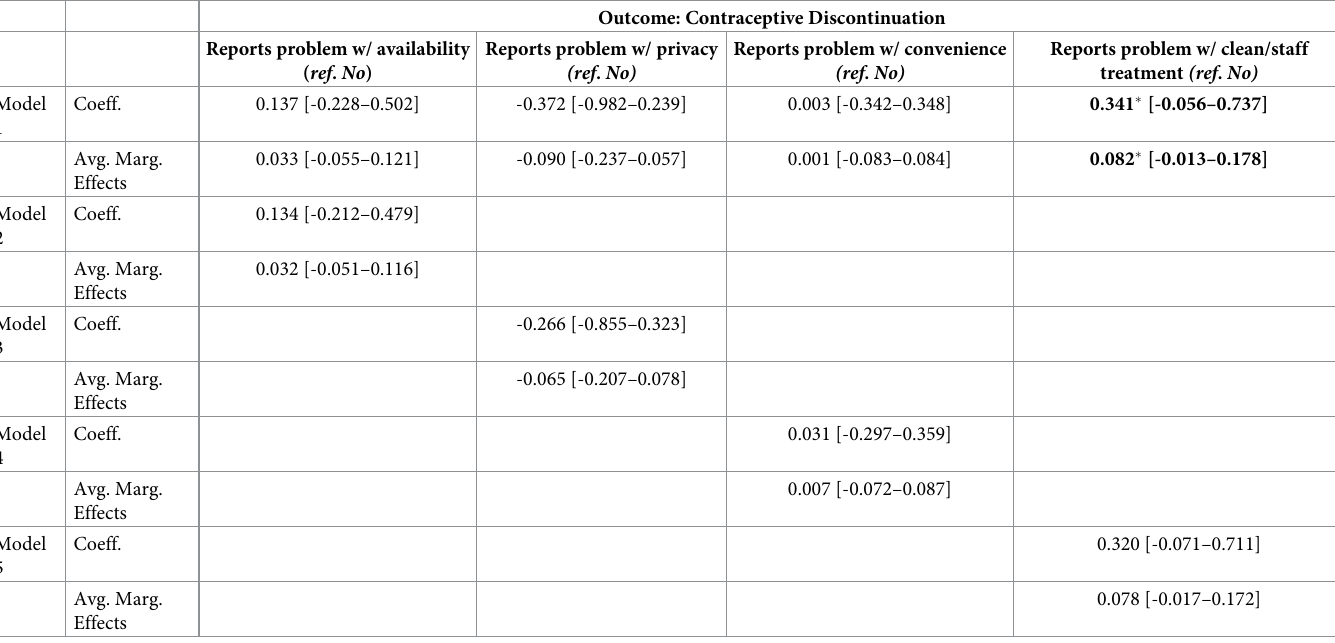
Table 3. Results from probit regression models of client dissatisfaction with family planning services on contraceptive